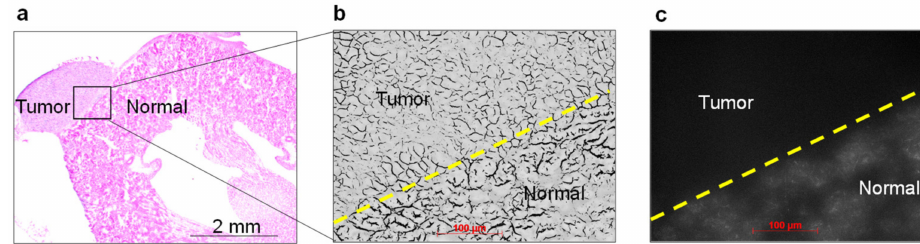
Figure 5. Histopathological analysis of the cancer tissue harvested from cancerous kidney after 10 min post-ASP5354 intravenous administration. ( a ) Hematoxylin and eosin (H&E)–stained tissue. ( b ) Monochrome image of boundary area between tumor and normal tissues in frozen section adjacent to the section used in ( a ). Yellow dashed line is the boundary between the tumor and normal tissues. ( c ) Near-infrared fluorescence image of section ( b ) by ASP5354. NIRF is displayed in white. Yellow dashed line is the boundary between the tumor and normal tissues.